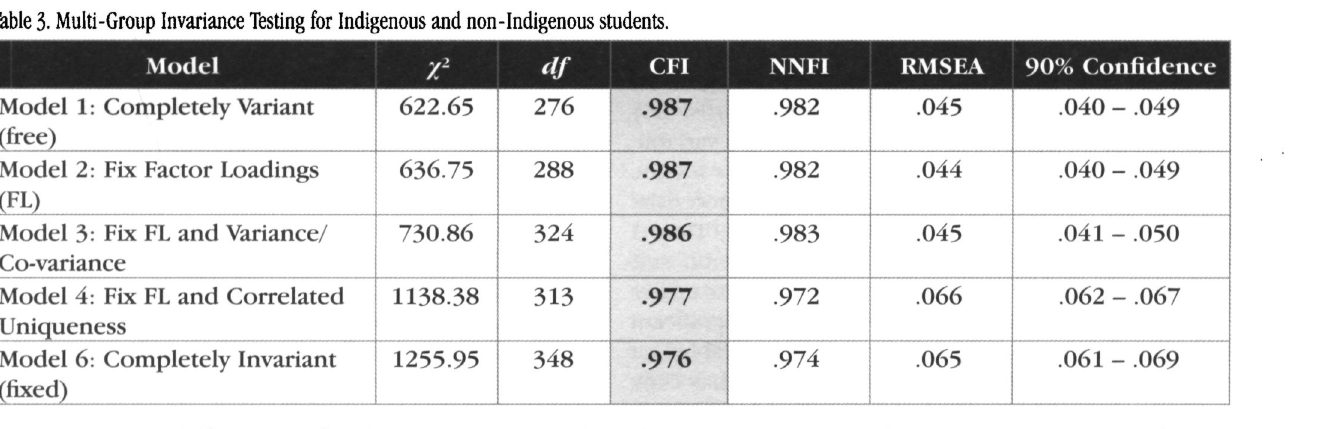
Table 3. Multi-Group Invariance Testing for Indigenous and non-Indigenous students.